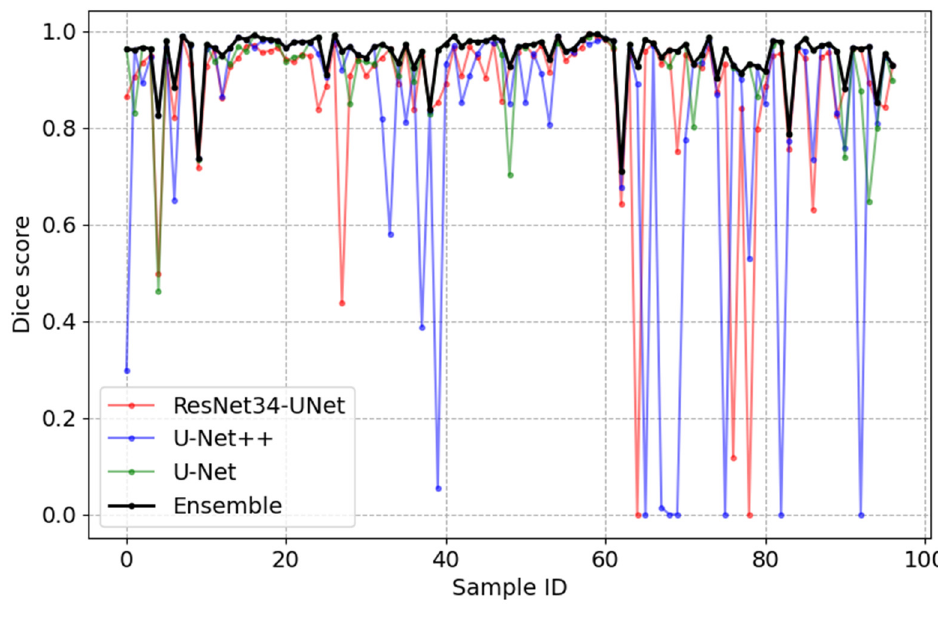
Figure 12. Relationship graph between the Dice score, tested image ID and segmentation model.